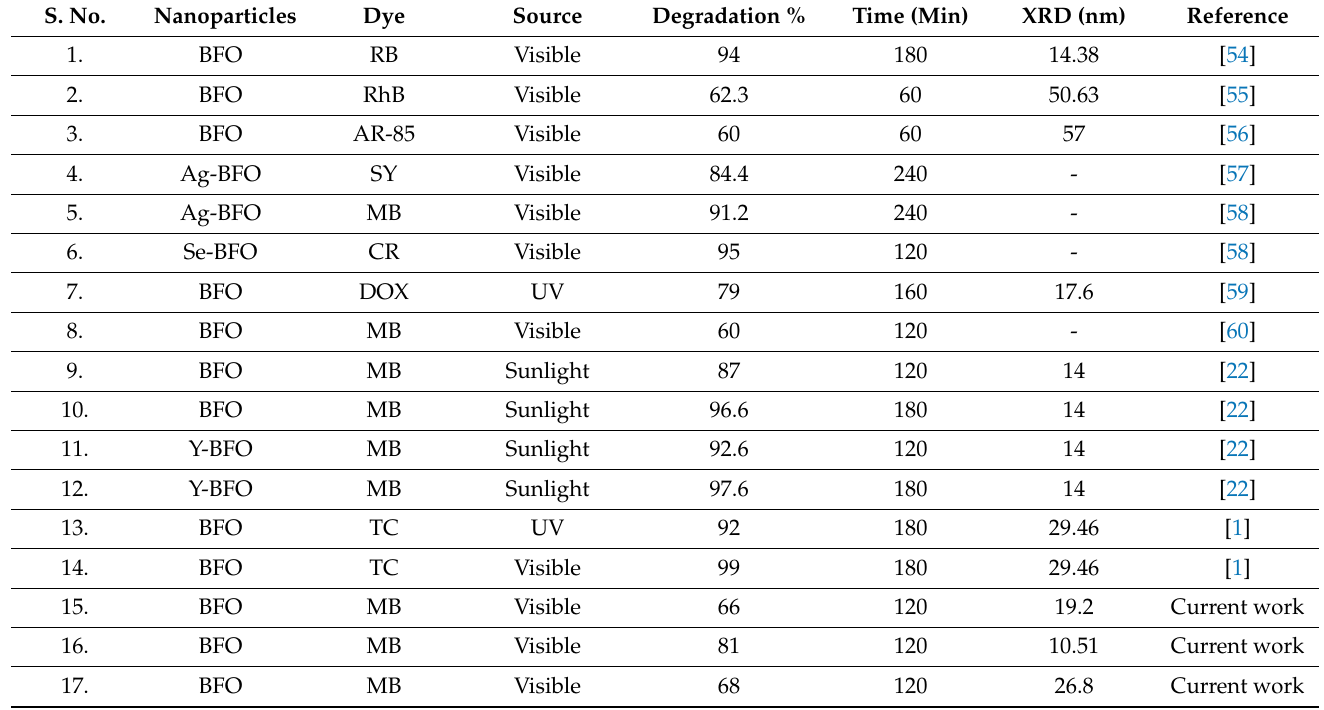
Table 3. Photocatalytic dye degradation of BFO nanoparticles in different